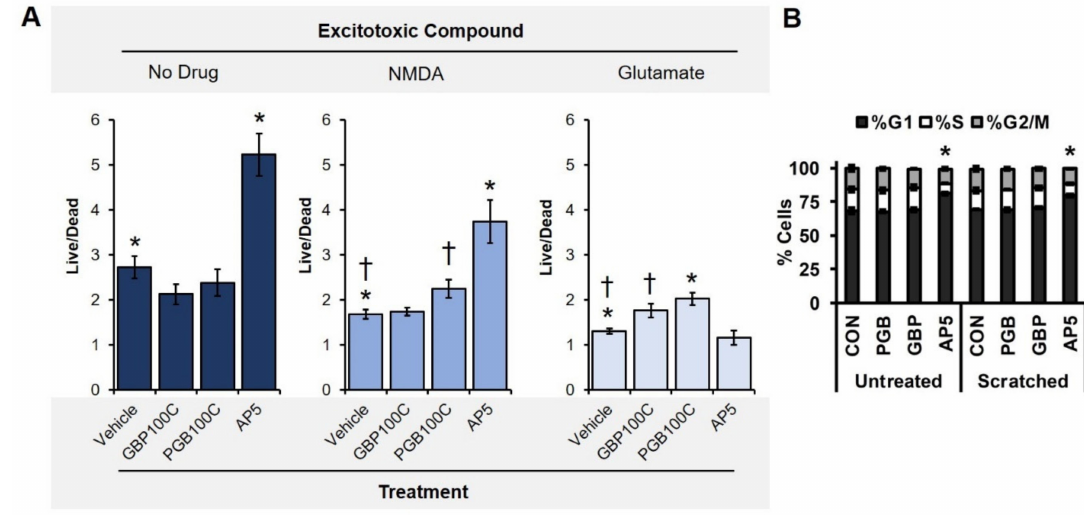
Figure 4. Live–dead imaging of primary cortical neurons exposed to excitotoxic compounds and drug conditions with confirmation of non-proliferation. ( A , left ) Chronic exposures to AP5 improved cell viability without the addition of an excitotoxic compound, mirroring e ff ects in 3D reported elsewhere. ( A , middle ) When NMDA was added to the culture media, both AP5 and PGB (100C) prevented excitotoxicity. ( A , right ) Glutamate-induced toxicity, however, was only prevented by VGCC blockers. Only significant di ff erences relative to the vehicle condition (control, no treatment) are indicated (* p < 0.001, † p < 0.05). (B) Percentage of primary cortical cells in the respective phases of the cell cycle after 24 h treatment with or without the shown perturbations. VGCCs showed no clear proliferative e ff ect upon cells with or without the simulated injury (scratch); a significant main e ff ect of AP5 on each cell cycle metric compared to all other treatment groups was noted (* p <